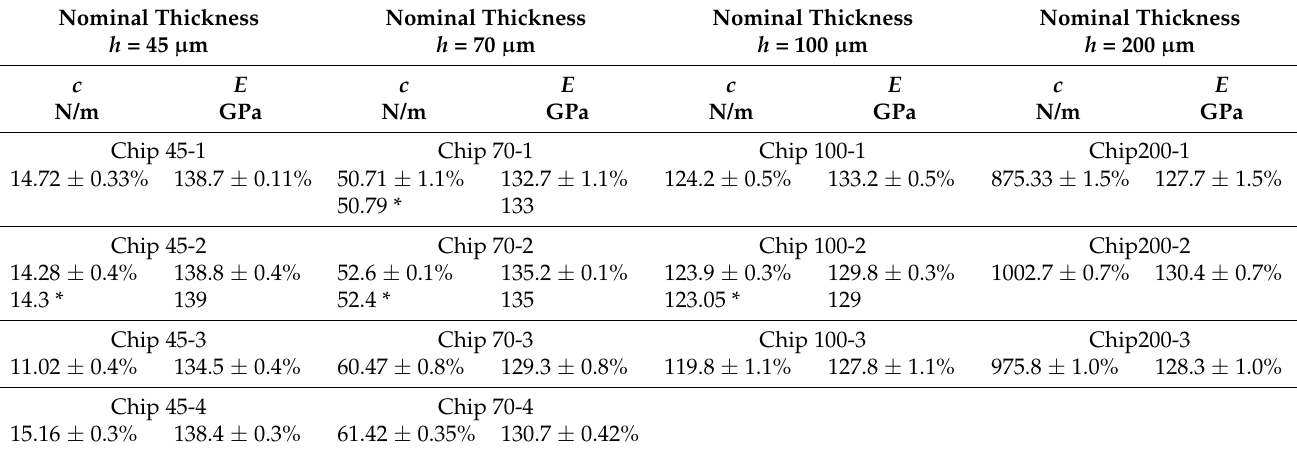
Table 3. Young’s modulus E calculated from the dimensions h , b , l and the measured stiffness. The errors of E are only based on the errors of the stiffness ( E <100> = 130 GPa is the nominal value).